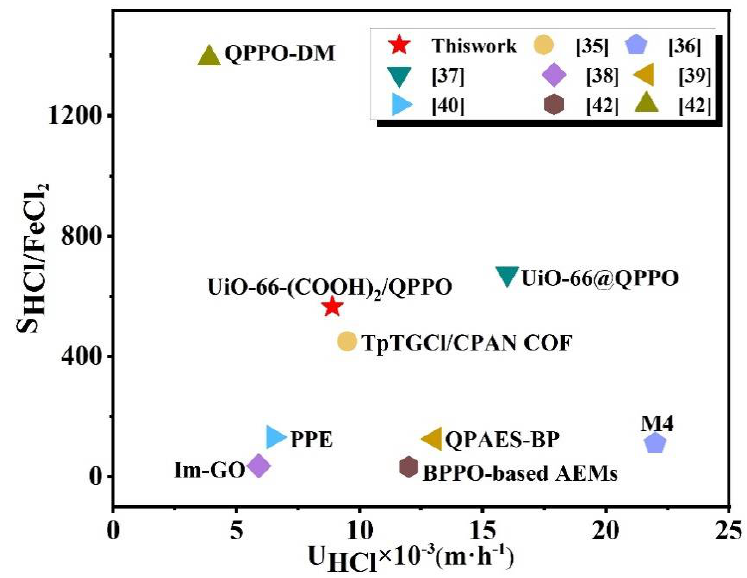
Figure 5. S HCl/FeCl2 versus U HCl of the reported membranes under diffusion dialysis [35–42].